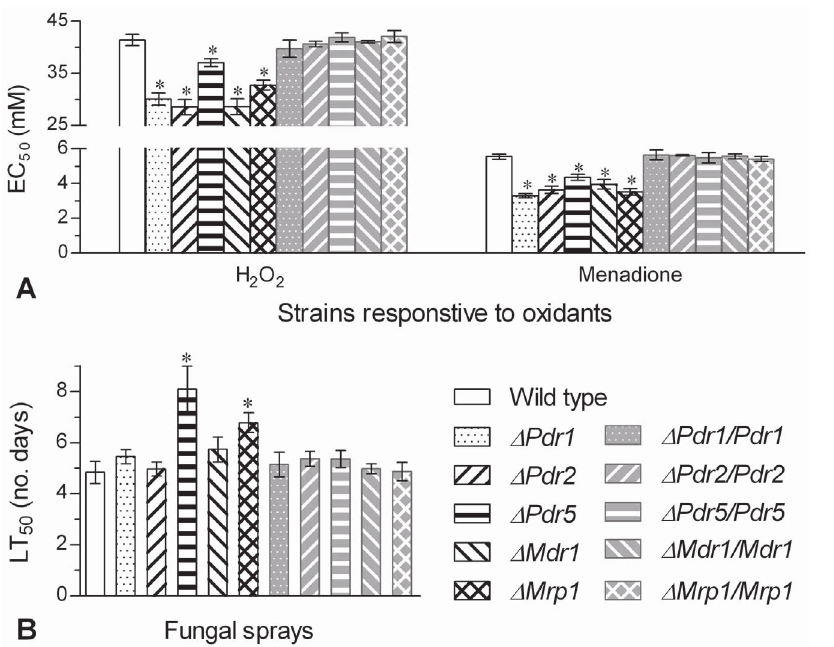
Figure 3. Changes in antioxidant capability and virulence of five single-gene disruption mutants of B. bassiana . (A) Effective concentrations (EC 50 s) estimated for H 2 O 2 and menadione to suppress 50% colony growth by modeling analysis of relative growth trends over the concentrations of 0 2 80 mM H 2 O 2 or 0 2 8 mM menadione added to 1/4 SDAY. (B) Median lethal times (LT 50 s) of wild-type and mutant strains against the second-instar larvae of S. litura under a standardized spray. The bars of each group marked with asterisks differed significantly from those unmarked (Tukey’s HSD, P , 0.05). Error bars: SD of the mean from three repeated assays.